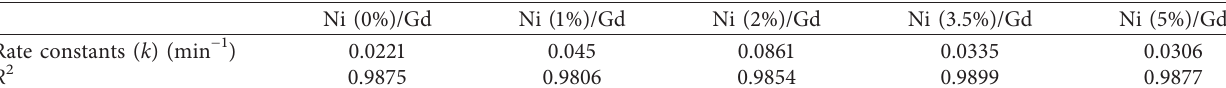
Table 3: Kinetic parameters of 40 mg · L − 1 RhB in electrochemical processes by Ti/SnO